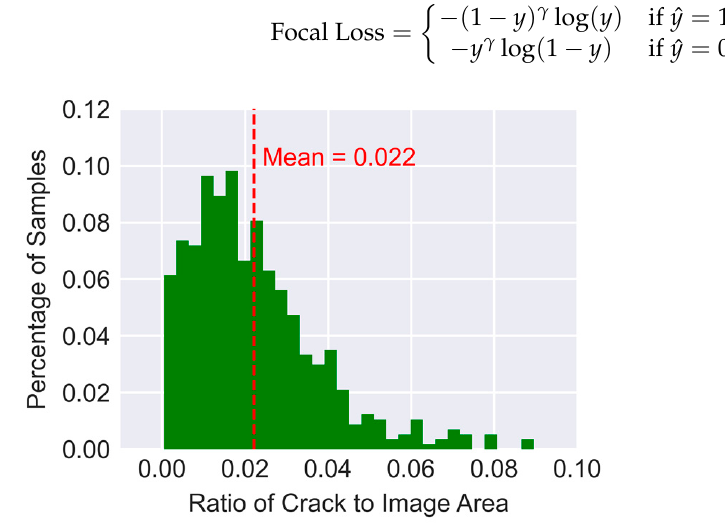
Figure 5. Distribution of crack-to-area ratio in the public dataset of 540 images.